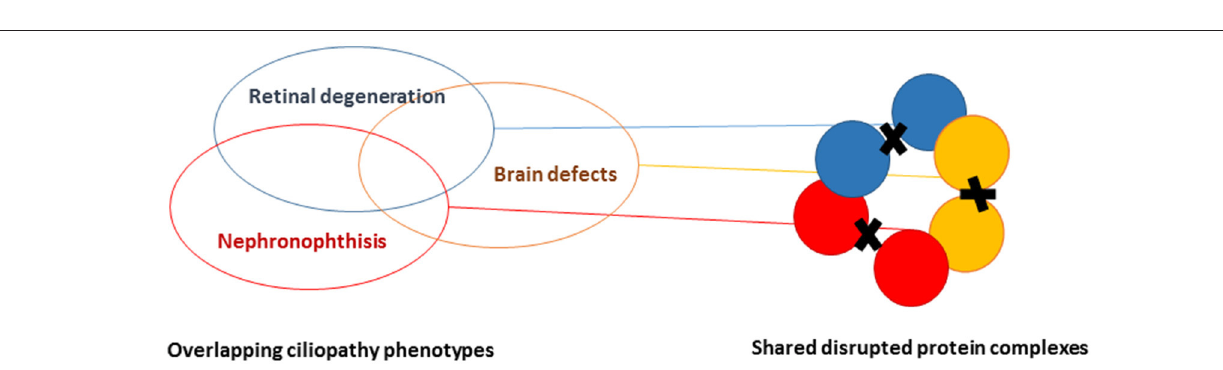
FIGURE 3 | Schematic representation of understanding proteomic modules underlying ciliopathies. By performing systematic agnostic proteomic profiling of protein complexes, it is possible to distinguish and find overlap in the disrupted protein modules in ciliopathies, featuring retinal degeneration, brain malformation, and/or renal